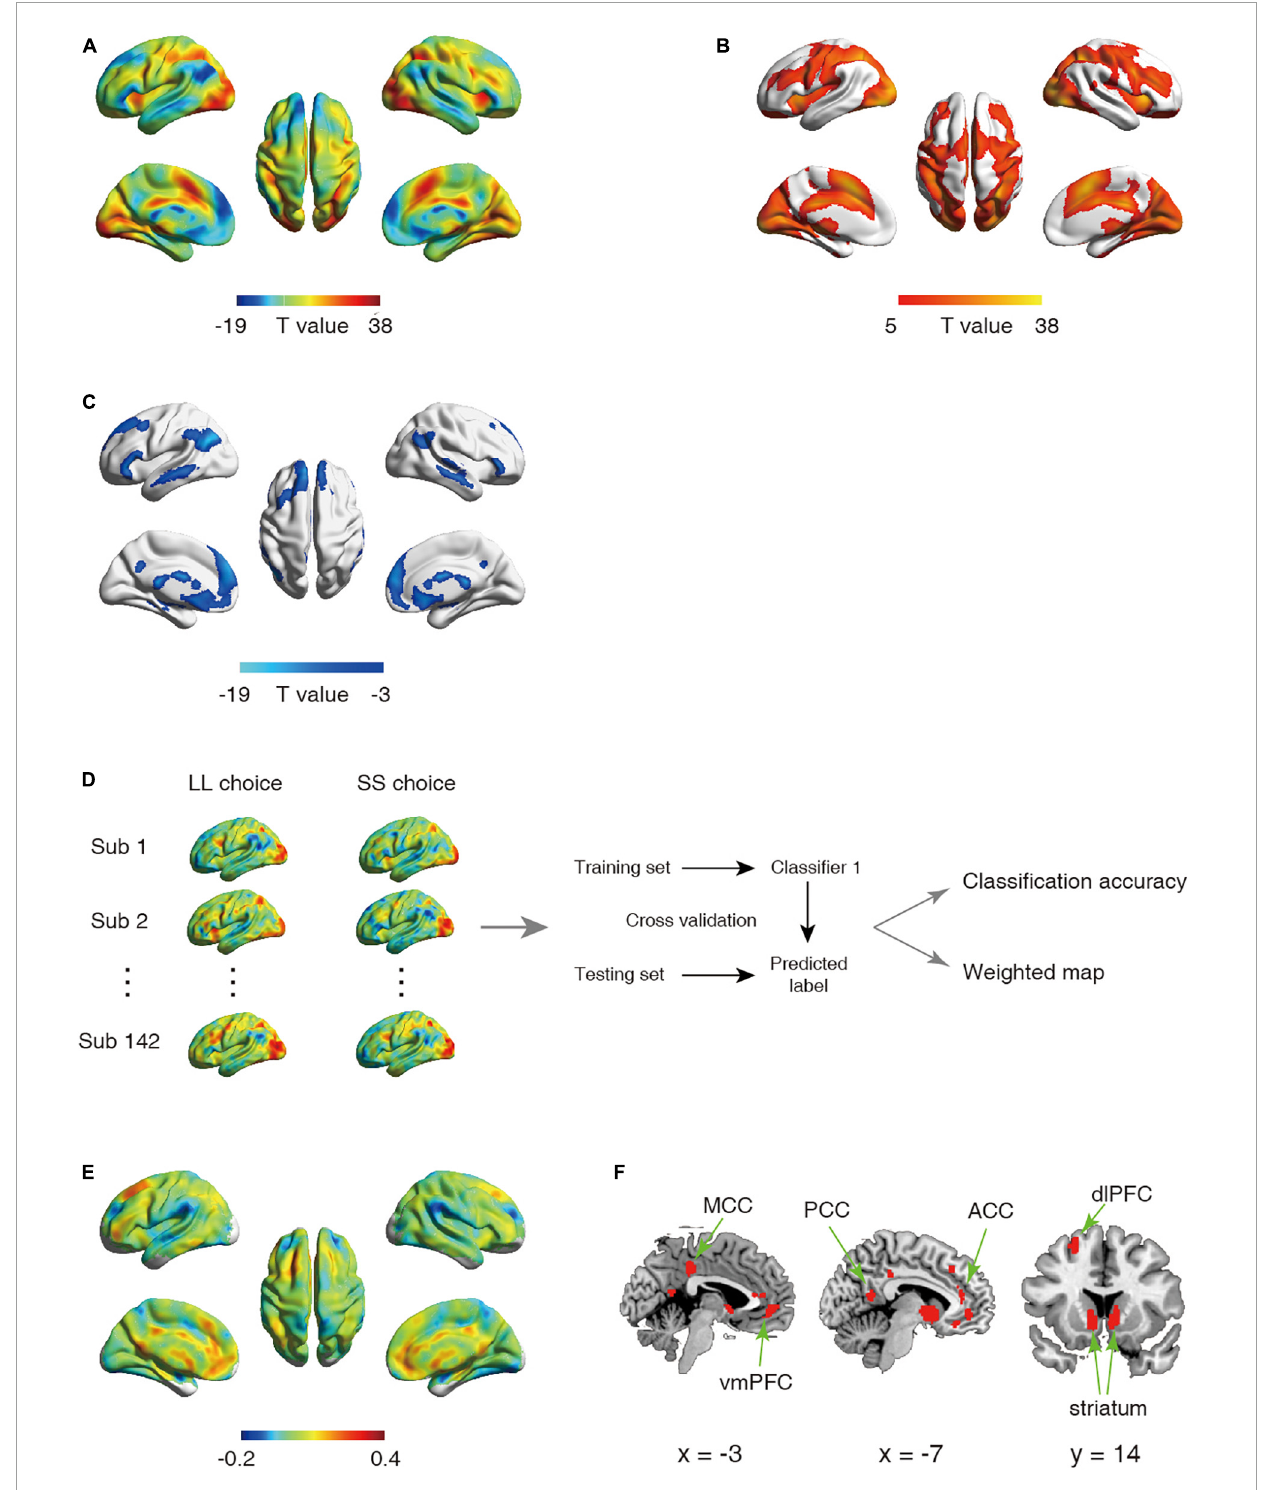
FIGURE1 (A–C) Statistical activation t-map in univariate analysis. (A) Statistical activation t-map for contrast LL vs. SS in univariate analysis, with warm color indicating stronger activation for LL relative to SS (regions exhibiting LL > SS were shown in (B) and cool color indicating stronger activation for SS relative to LL (regions exhibiting SS < LL were shown in (C) (Significant threshold: p FWE < 0.05). (D–F) Schematic overview of analysis for first classifier and corresponding results. (D) The univariate analysis was first used to obtain the activation maps for larger later choice (LL choice) and small sooner choice (SS choice) from each participant. The whole-brain activated parametric values from the LL choice and SS choice activation maps for each participant ( n = 142) were extracted as the features, which were then used to build classifier. (E) The whole-brain weighted map. The color bar indicates weight value. (F) The top 1% voxels with highest weights (absolute value). Specially, all these voxels were with positive